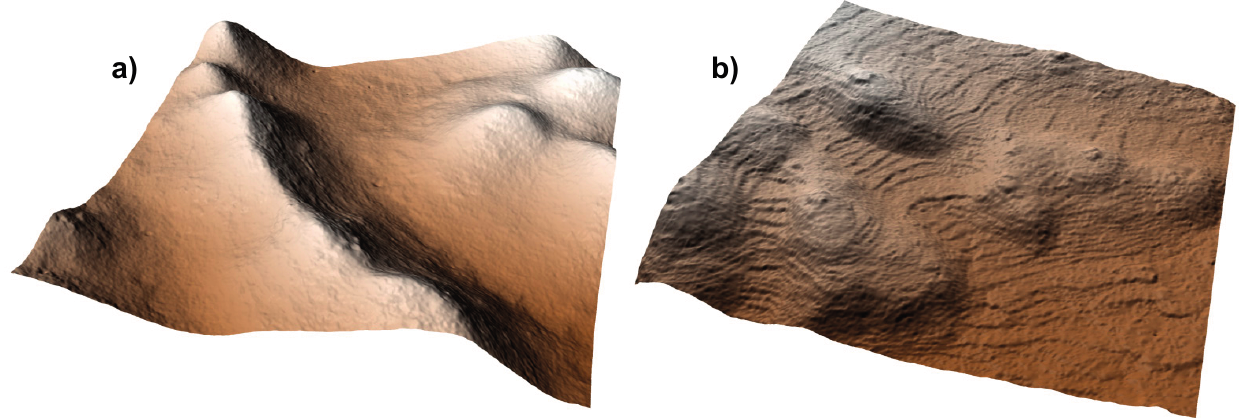
Figure 4. Example of a ( a ) 0.25 ha point cloud of rainforest canopy and ( b ) associated histogram of proportions of returns binned into 3 m height